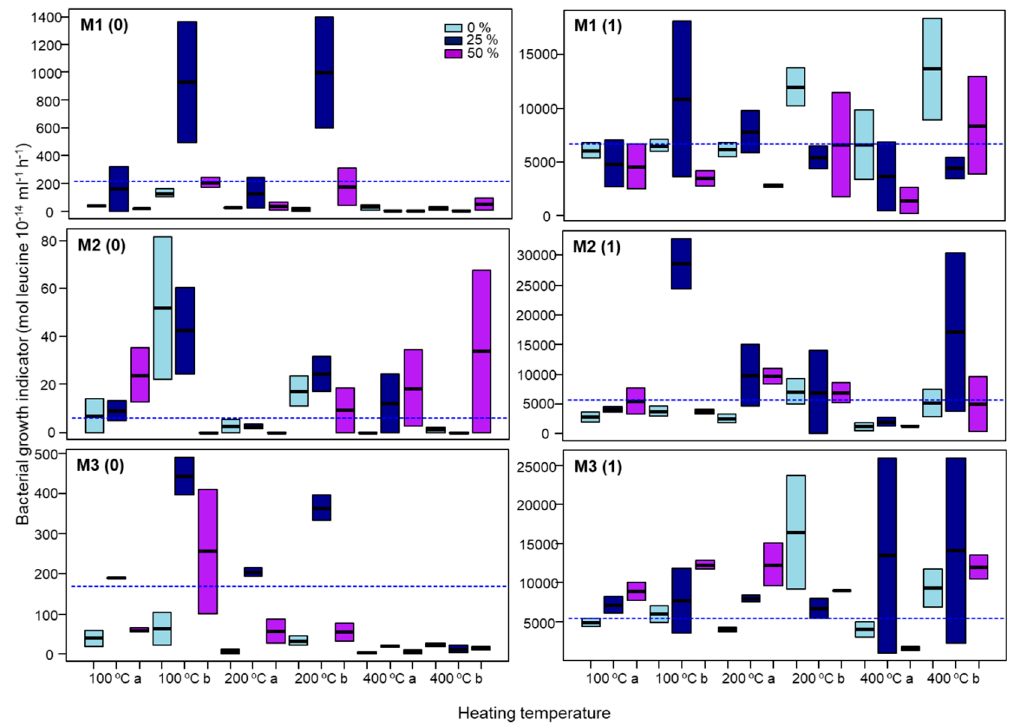
Figure 3. Bacterial growth immediately (0) and one month after the incubation (1) of the soil mixtures with 0%, 25% and 50% of initial soil water content, before heating at 100 °C, 200 °C and 400 °C. M1, soil mixture 1; M2, soil mixture 2; M3, soil mixture 3; a, soil layer (0–2 cm); b, soil layer (2–4 cm). The boxes represent the interquartile range and the horizontal lines within those boxes are the median. The dash line represents the intercept of the GLM model.